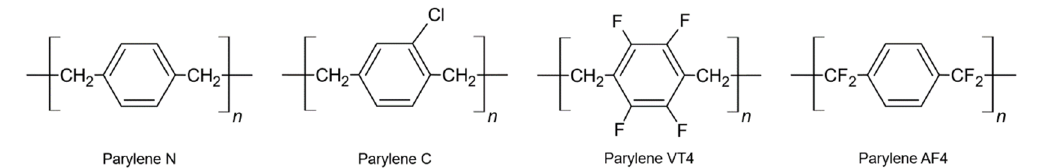
Figure 1. Chemical structure of parylene type N, C, VT4, and AF4.